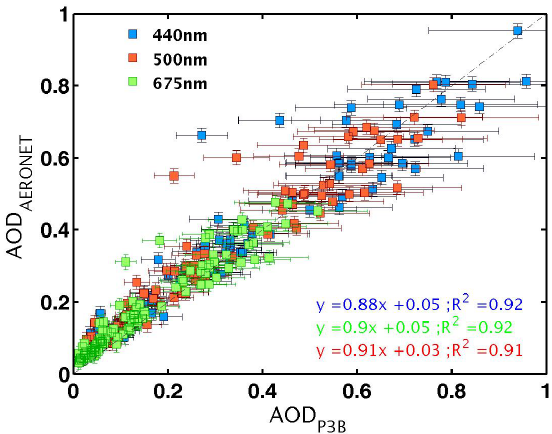
Fig. 2. Ozone measured from the EPA ground sites (at Beltsville, Padonia, Fairhill, Aldino, Edgewood and Essex) as a function of the ozone measured on-board the P-3B at the lowest level of each profile.